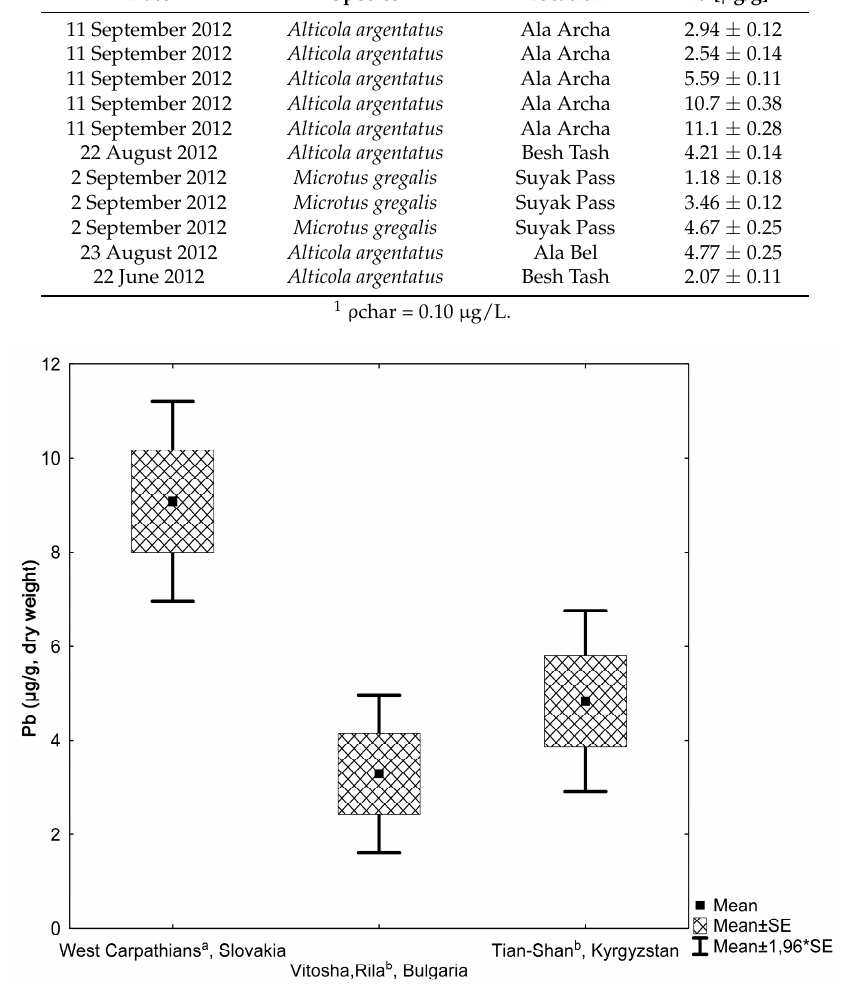
Figure 1. Mean lead concentrations (µg/g dry weight) in the tail vertebrae of voles from the Tatra, Vitosha and Rila mountains, and Tian-Shan mountains. Groups with different indices are significantly different at p = 0.05 (One-way ANOVA, Fisher’s LSD test).